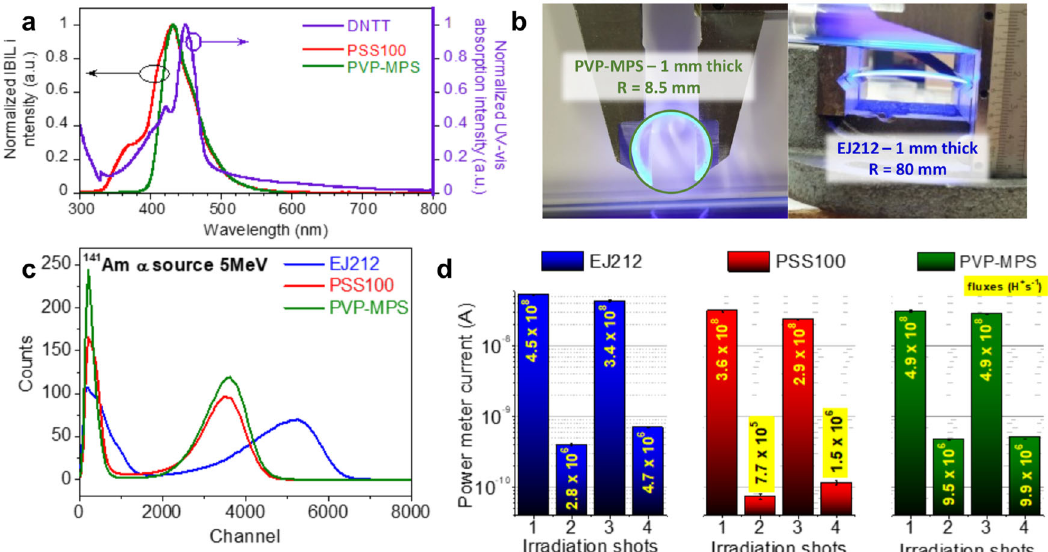
Fig. 2 Characterization of the plastic scintillator. a Normalized ion beam-induced luminescence (IBIL) spectra of scintillators based on PSS100 and PVP-MPS matrices, collected at fl uences of about 5 × 10 8 H + s − 1 at 2 MeV (left axes, the experimental setup is reported in Supplementary Fig. 3). Comparison with the UV – vis absorbance spectrum of the DNTT (right axes). b Pictures of PVP-MPS siloxane scintillator (left) and commercial EJ-212 (right) under different bending conditions: the elastic siloxane undergoes severe deformation without cracking under negligible applied stress, whereas the EJ-212 of the same thickness must be strained in an iron grip to achieve a barely visible curvature. The reader can refer to Supplementary Table 2 for further information on the base matrix features. c Scintillation pulse height spectra of PSS100 (red line) and PVP-MPS (green line) scintillators. The spectrum of EJ212 (blue line) is shown for comparison. d Response measured with a power meter of the different scintillators at repeated shots in the same spot with alternating high and low 5 MeV proton beam fl uxes, as indicated in correspondence of the bars. The values measured for EJ-212 are also shown for